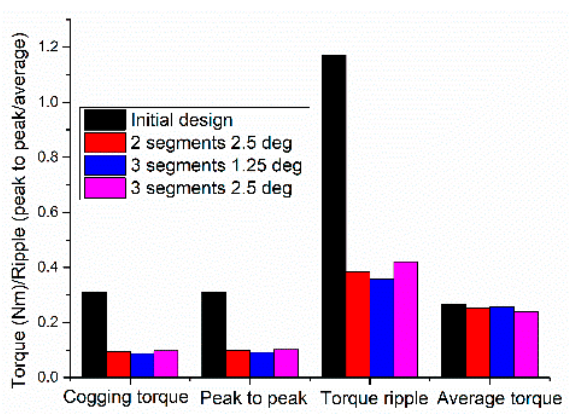
Figure 18. The overall conclusion of three different machine designs.